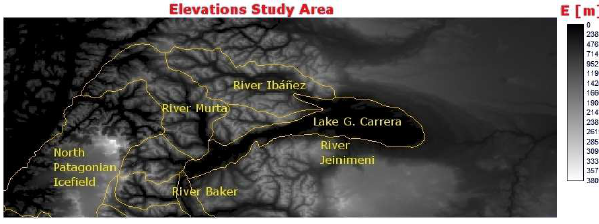
Fig. 6. Main rivers within the basin of Lake General Car- Main rivers within the basin of Lake General Car- Main rivers within the basin of Lake General Car- rera/Buenos Aires/Chelenko. rera/Buenos Aires/Chelenko. Main rivers within the basin of Lake General Car- rera/Buenos Aires/Chelenko. rera/Buenos Aires/Chelenko.